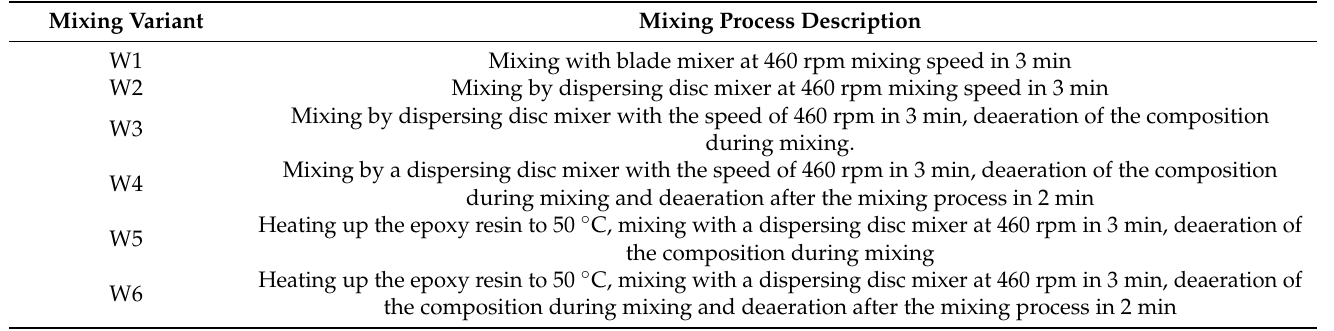
Table 4. Parameters of each mixing variant.